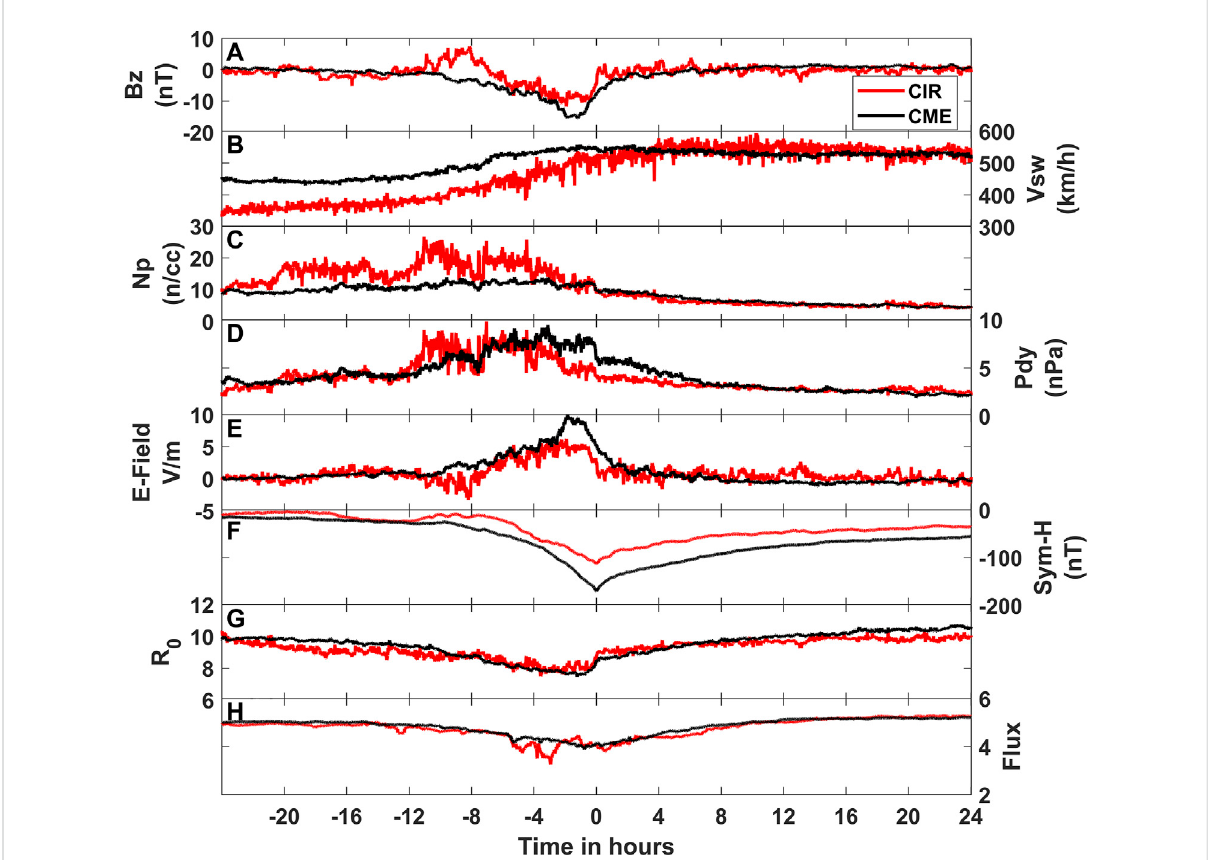
FIGURE 3 Superposed epochanalysis performed on thevarious interplanetaryconditions: (A) IMF Bz (nT), (B) solar wind speed, Vsw (km/h), (C) solar wind density, Np (n/cc), (D) solar wind dynamic pressure, Pdy (nPa), (E) electric fi eld (V/m), (F) Sym-H (nT), (G) magnetopause stand-off distance, R 0 (R E ), and (H) GOES > 0.6 MeV electron fl ux (e cm − 2 s − 1 sr − 1 ) for different solar structures such as CME (black curve) and CIR (red